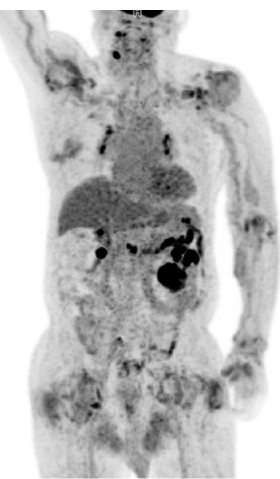
Figure 1. Maximum intensity projection of 18 F-FDG PET-CT demonstrated increased metabolic activity in the shoulders, left elbow, left wrist, left hand and